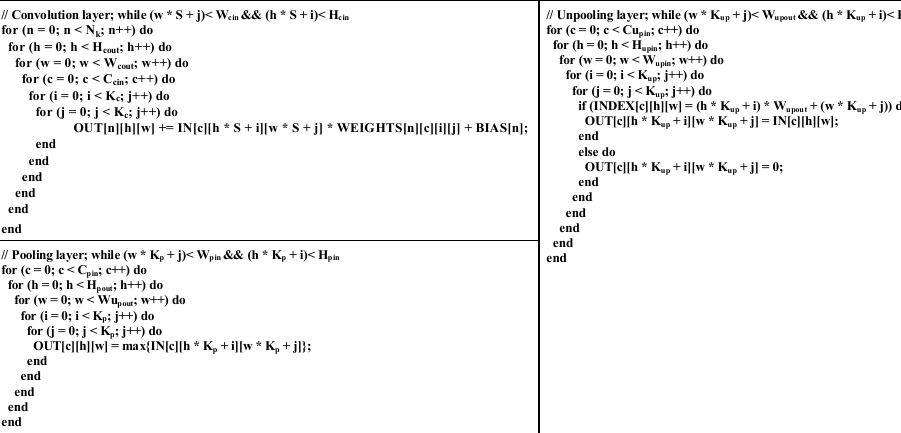
Figure 2. Code description of convolutional, pooling, and unpooling layers.